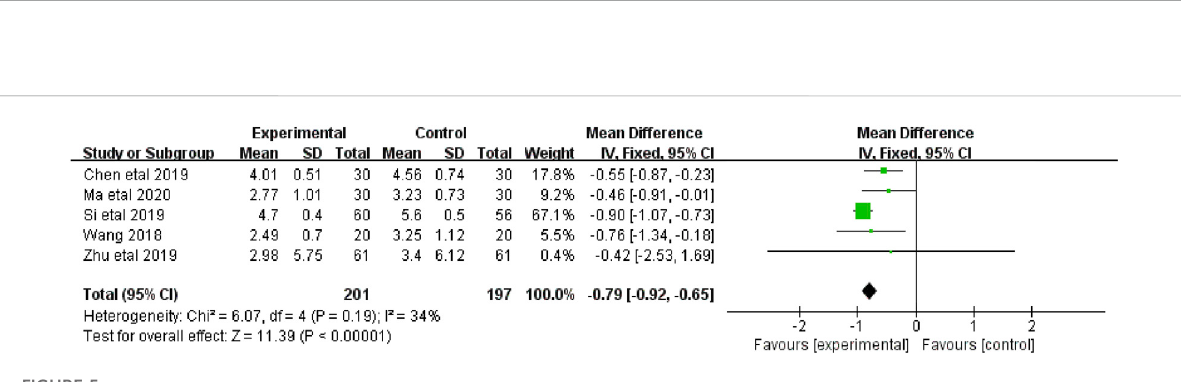
FIGURE 5 The forest plot of affective subscales of PFS